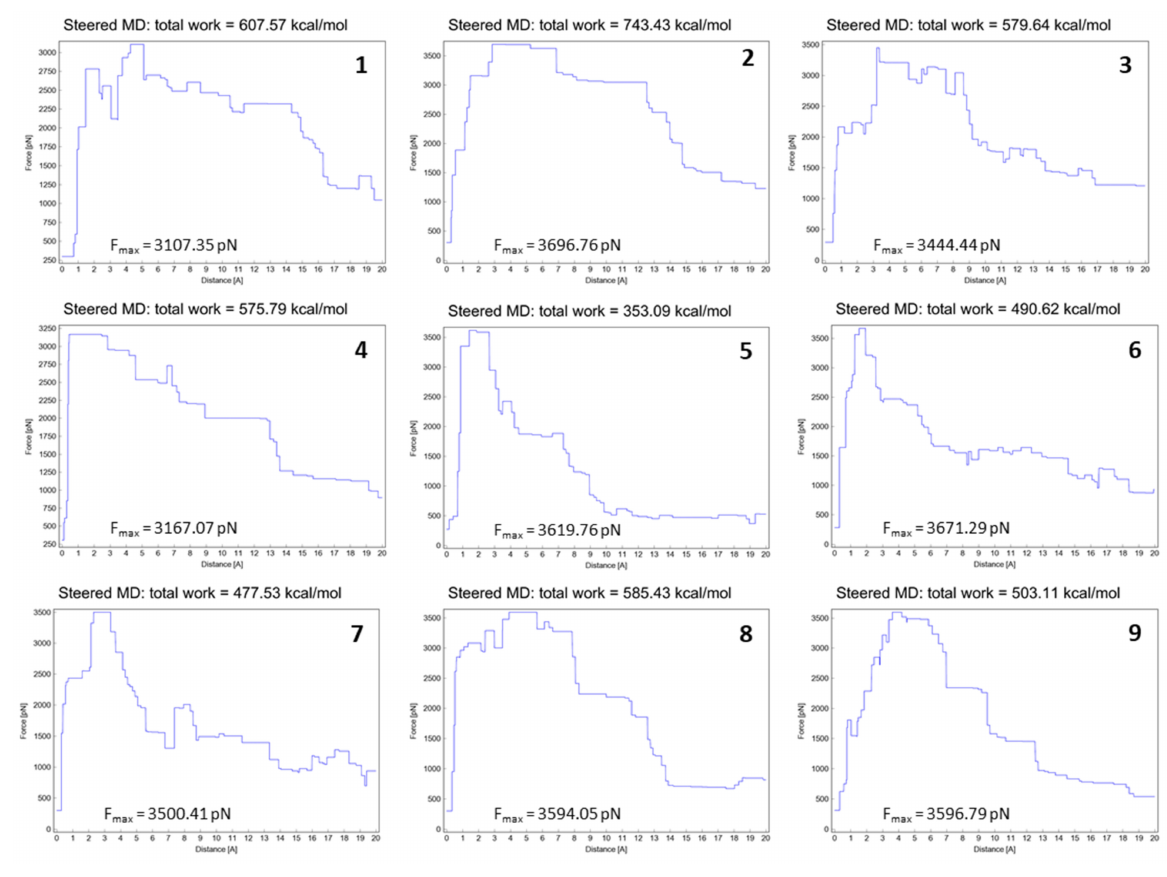
Figure 2. Total energies and F max from SMD experiment (20 Å) for molecules 1 – 9 . Table 2. FABP4 experimental K i and free energy of binding; ∆ G bind calculated with Autodock, Vina, MM/PBSA, and MM/GBSA (kcal/mol).